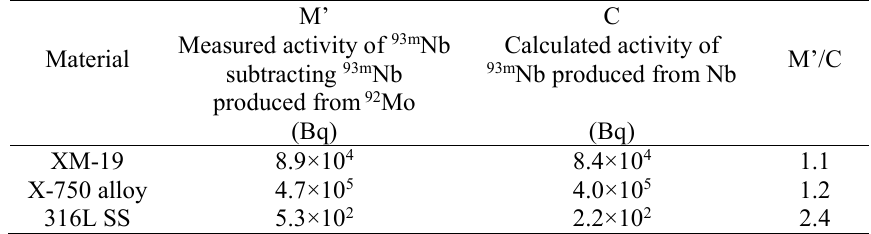
Table 6. Comparison of the measured activity of 93m Nb subtracting 93m Nb produced from 92 Mo and the calculated activity of 93m Nb produced from